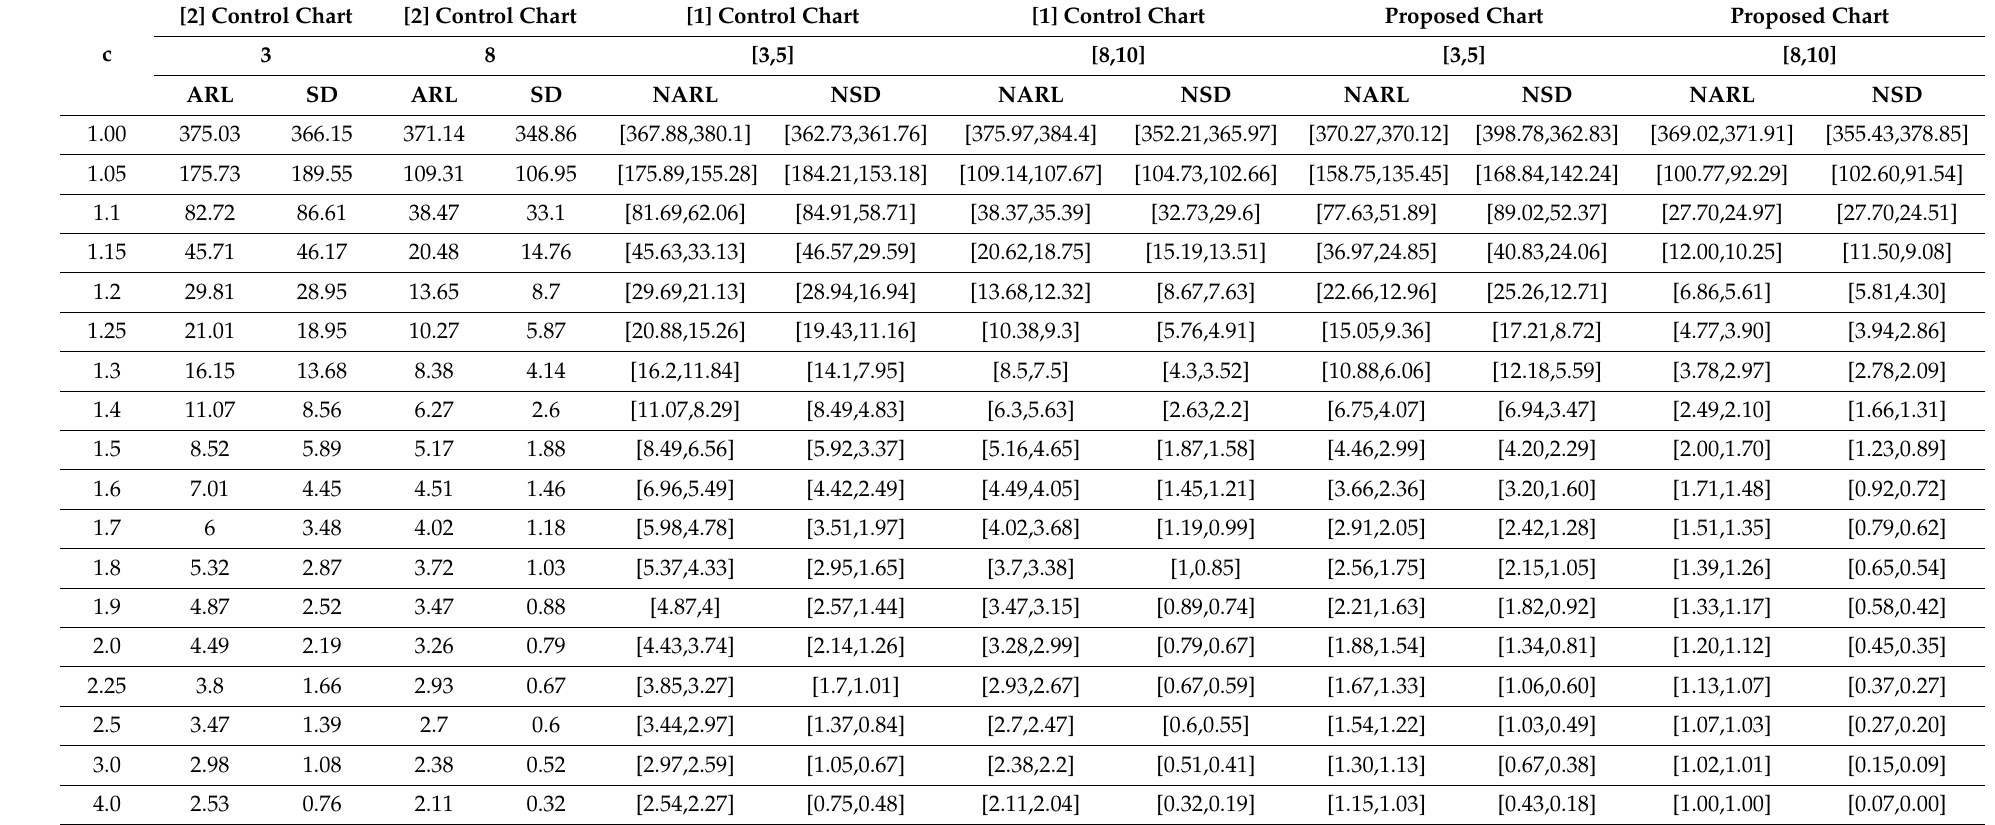
Table 7. The NARL values for the proposed chart and existing chart when I λ U =